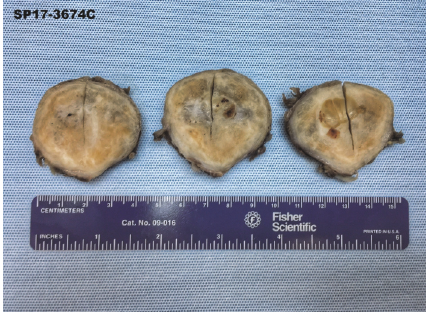
Figure 5: Microscopic (100x) H & E stained tumor revealing nests of round and polygonal cells with granular, eosinophilic cytoplasm classic for oncocytoma.